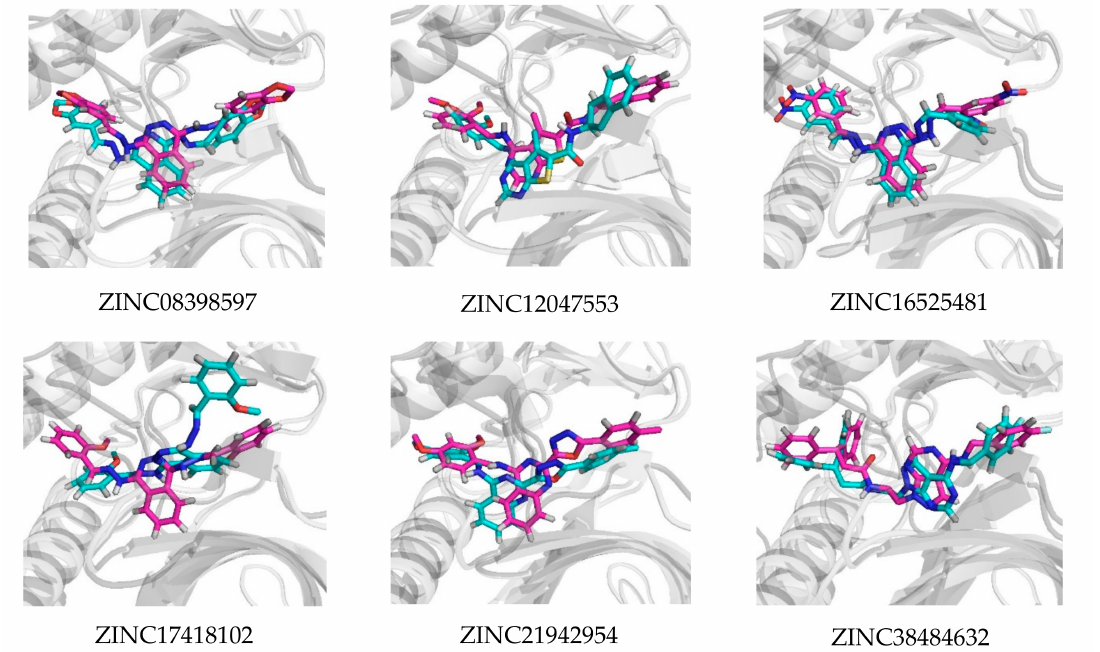
Figure 9. Superimposed ligand binding poses of the potential compounds at 0 ns (magenta) and 50 ns Int. J. Mol. Sci. 2020 , 21 , x FOR PEER REVIEW 11 of 16 (cyan) in their complex with VEGFR2.